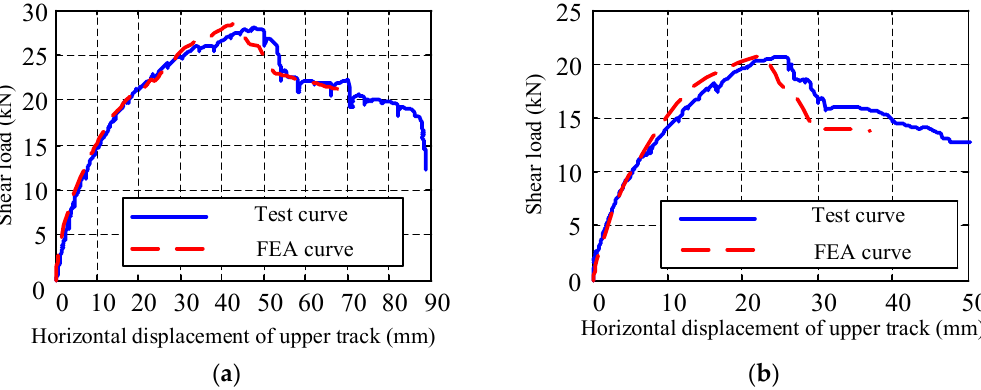
Figure 20. Comparison of load–displacement curves between the FEA and the test: ( a ) FW-1 (W-1), ( b ) FW-2 (W-2).